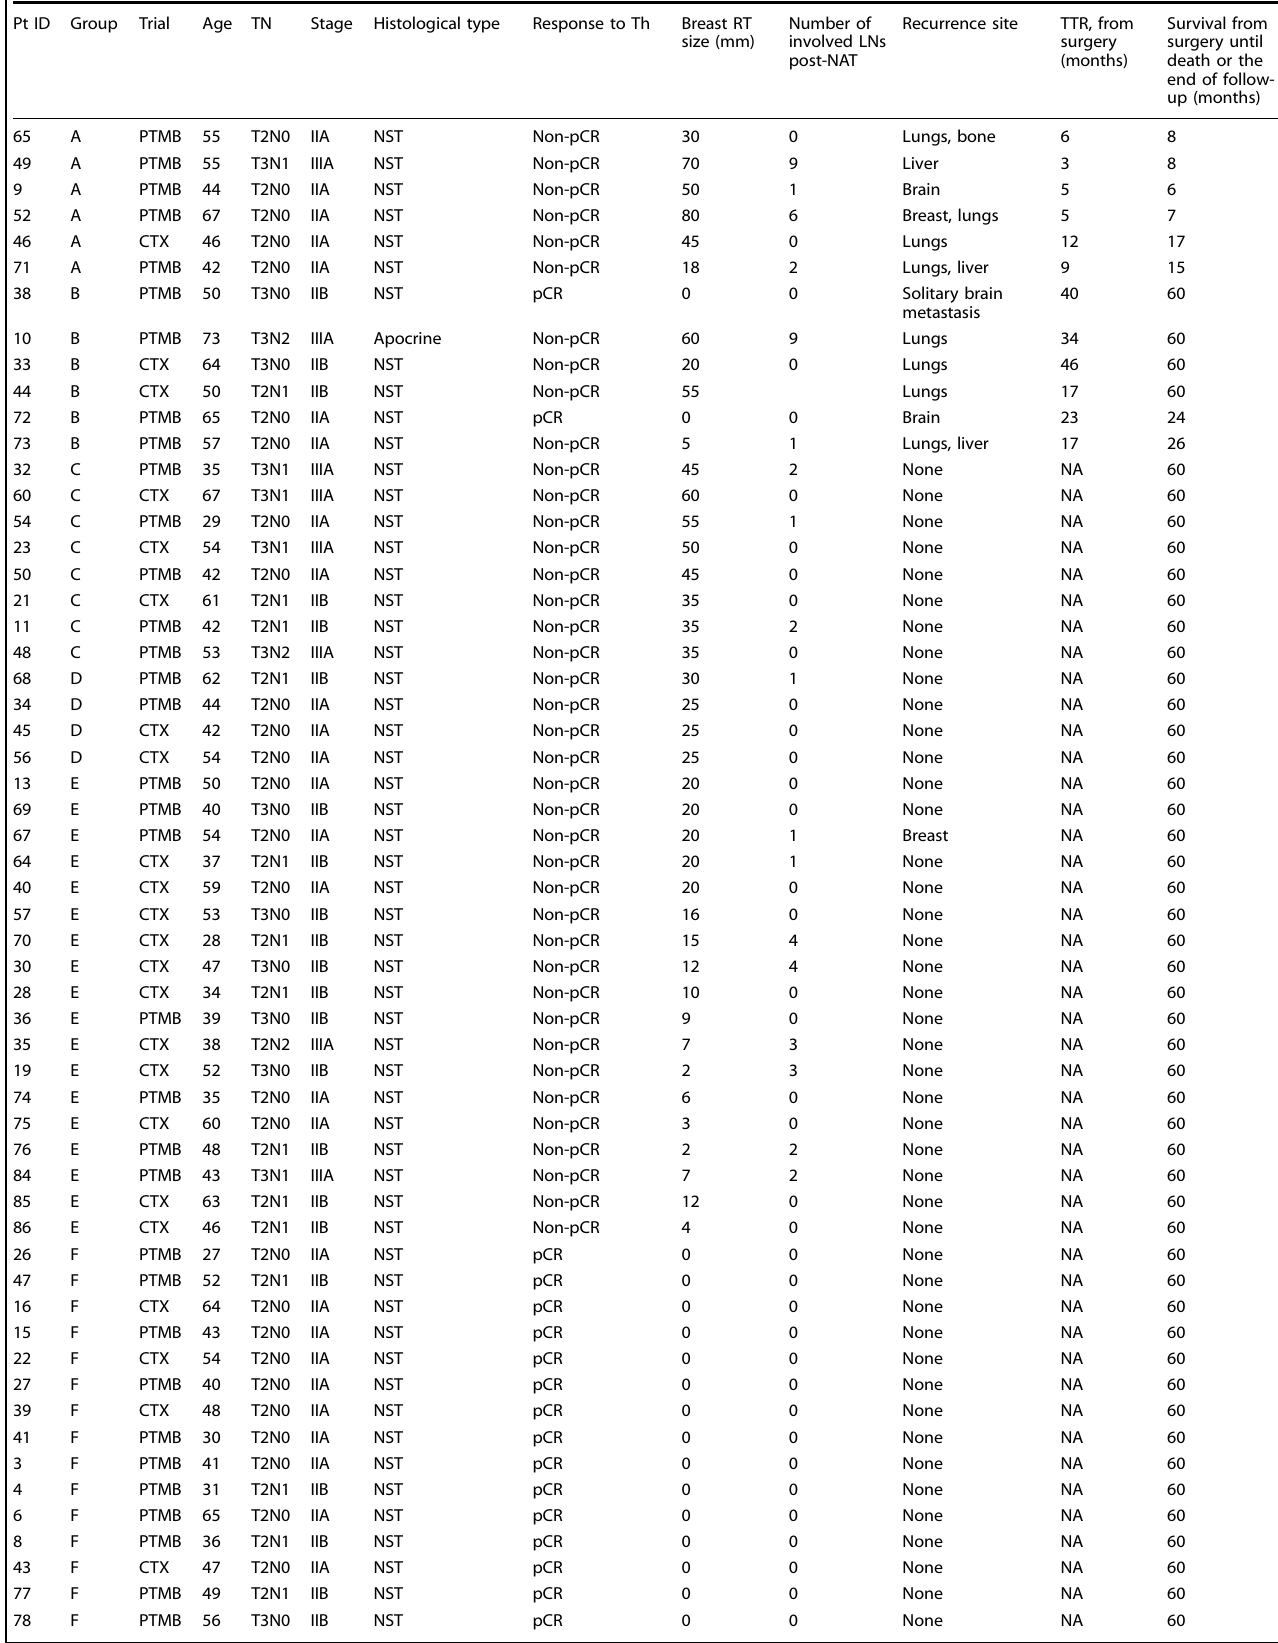
Table 1. Patient clinical